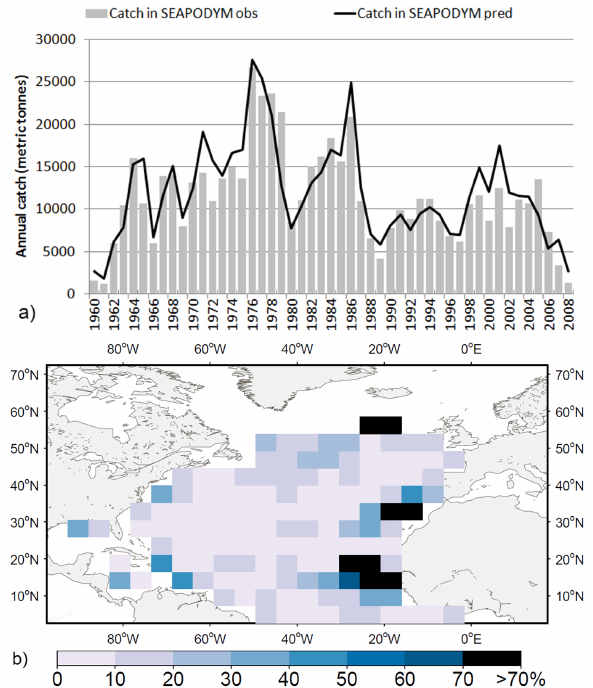
Figure 8. Fit to catch data. (a) Total annual predicted and observed catch used in SEAPODYM simulation. (b) Relative error in pre- dicted catch aggregated in 5 ◦ squares for the period